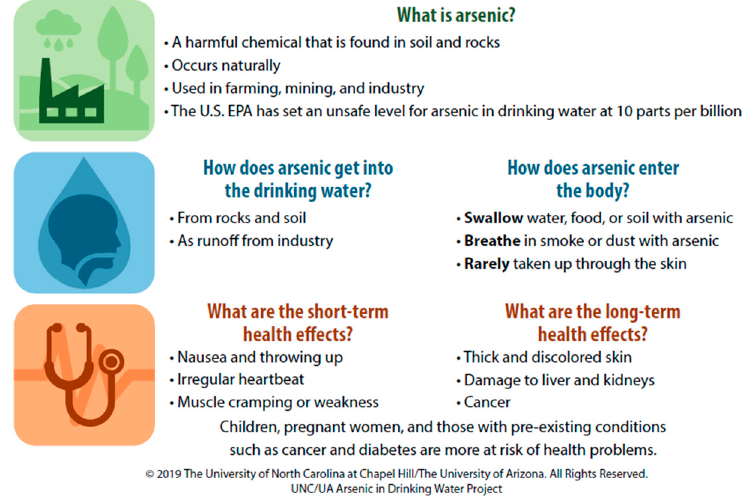
Figure 2. Arsenic and Health Handout.